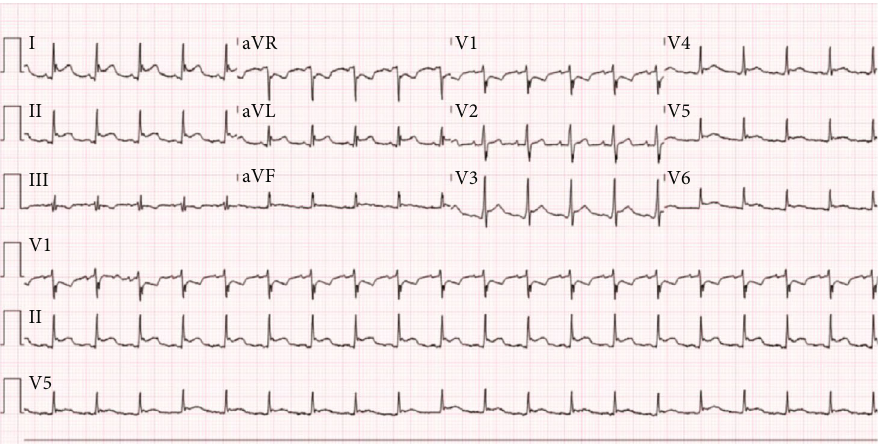
Figure 1: Electrocardiogram with tall ST-segment elevations in leads V3-V6, I, II, and aVL with ST-segment depressions in V1, aVR, and III.